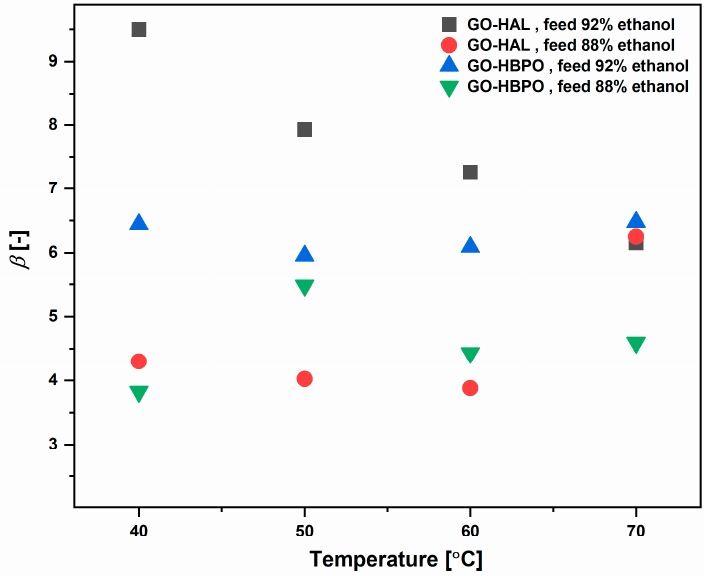
Figure 7. Separation factors for the pervaporation runs.